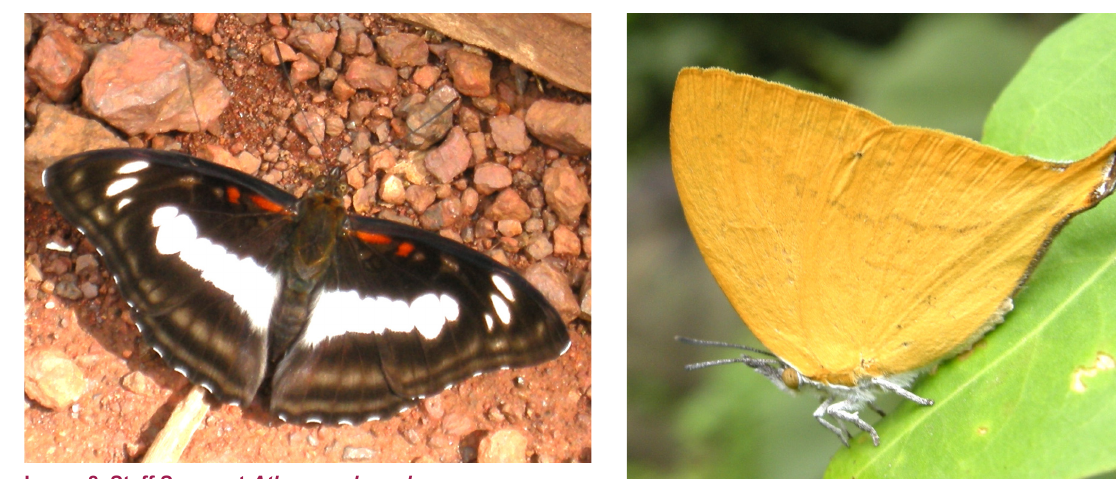
Image 8. Staff Sergeant Athyma selenophora